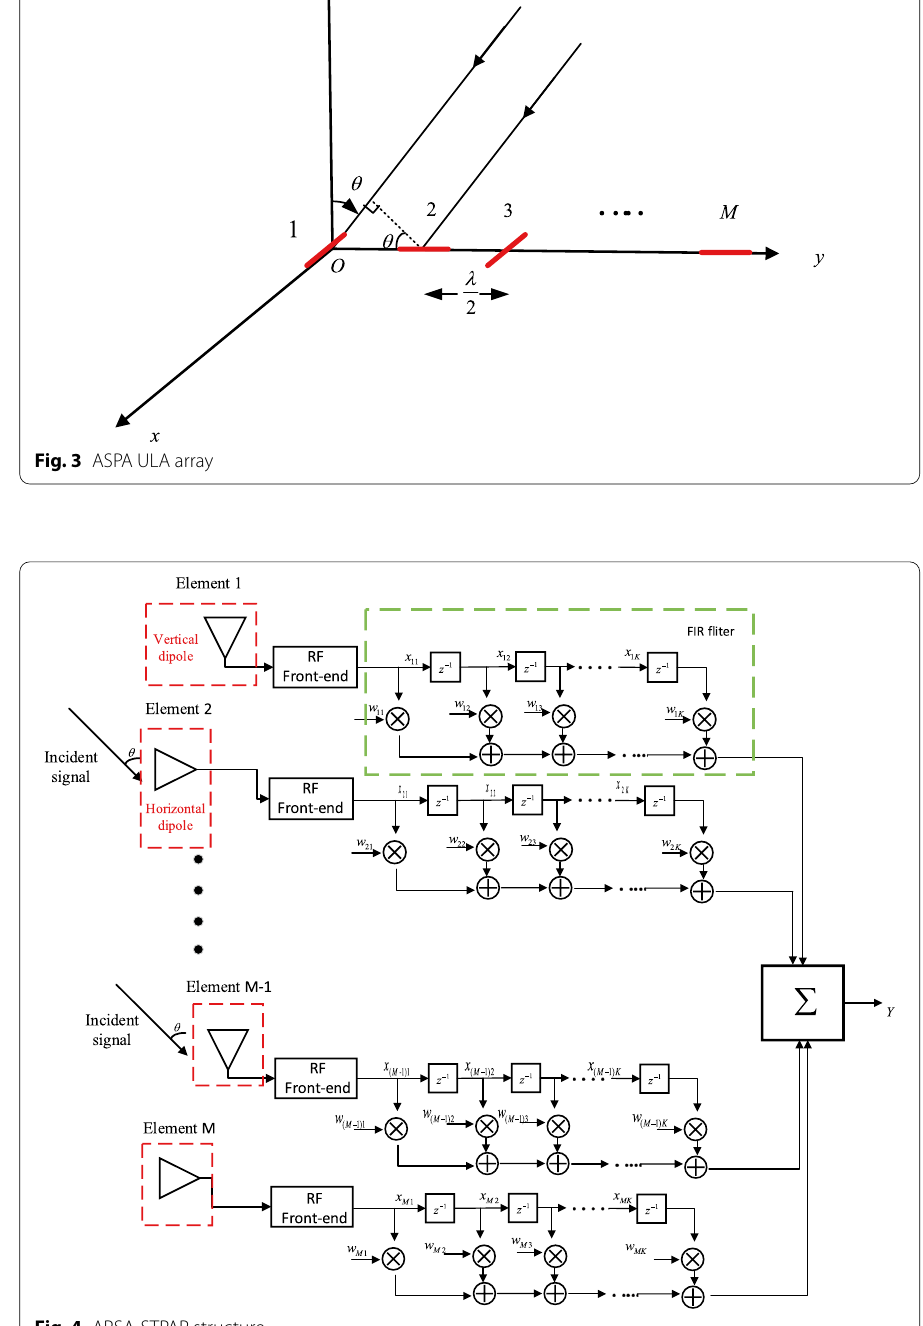
Fig. 4 APSA-STPAP